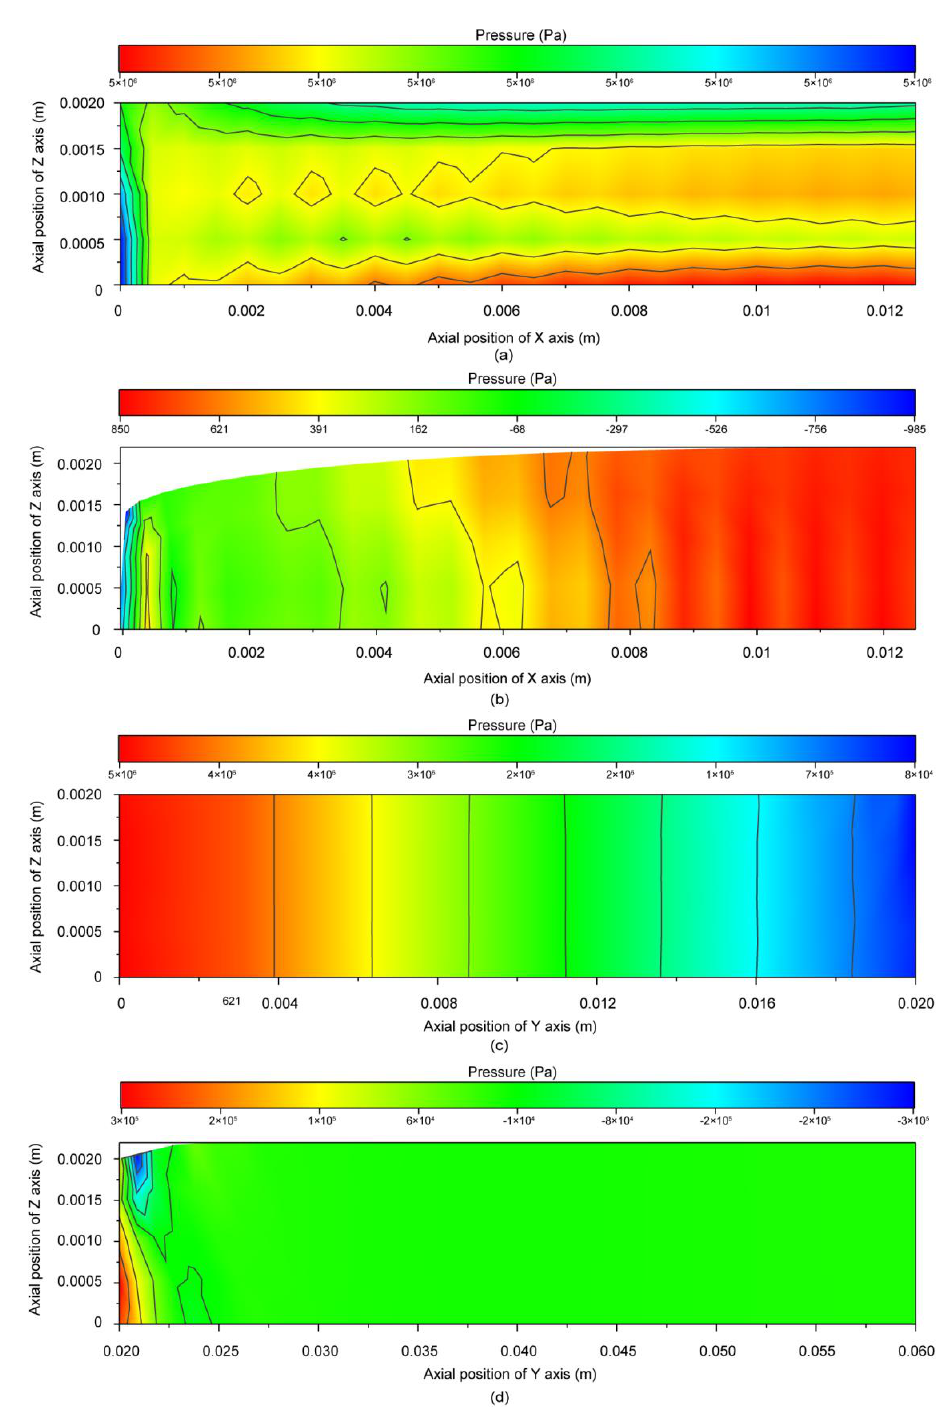
Figure 3. The pressure field distribution of the WPC with 40% wood fiber as an example. Pressure distribution at: ( a ) the inlet; ( b ) outlet; ( c ) on the plane of symmetry 1; ( d ) on the plane of sym- metry 2.